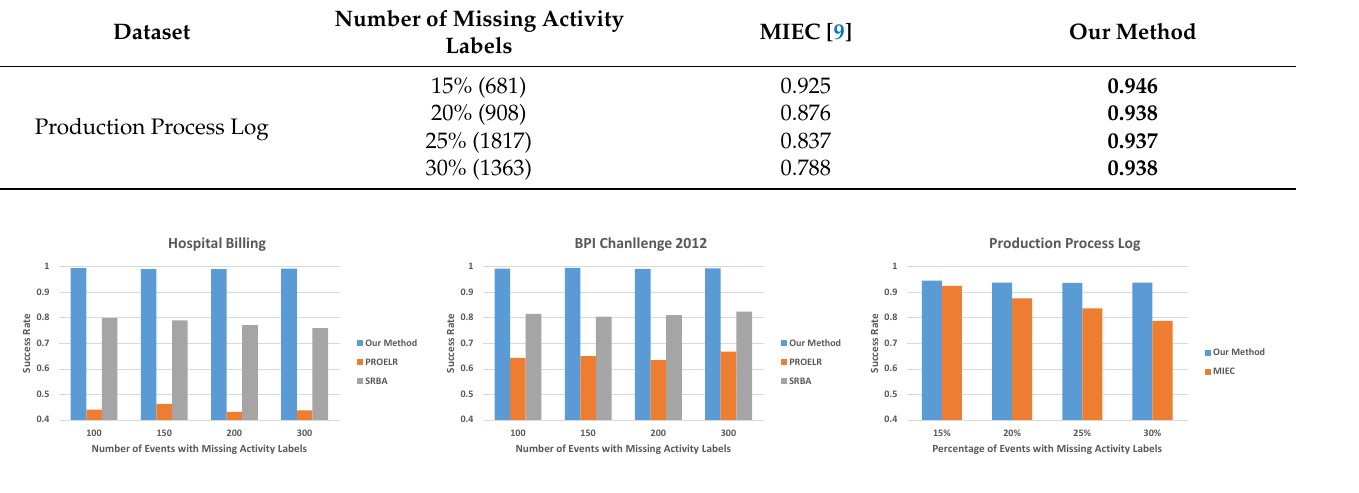
Figure 7. Comparison of our method with